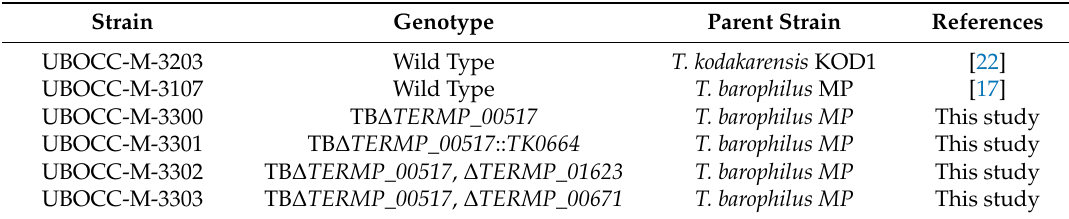
Table 1. Thermococcus barophilus strains used and constructed in this